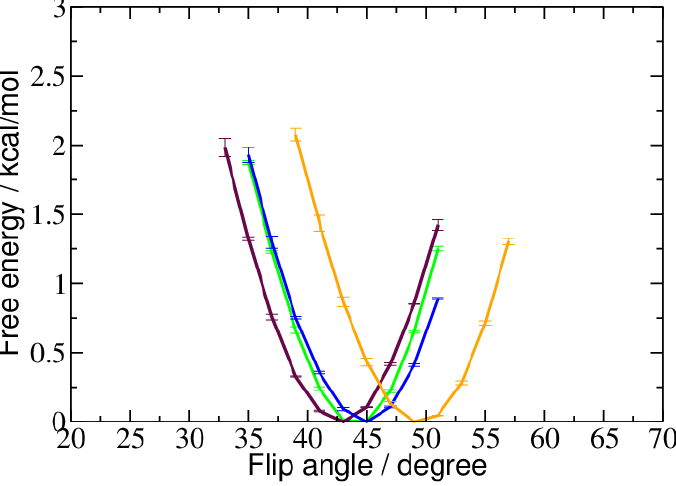
Figure 3. Free energy profiles of the pseudo-dihedral flip angle evaluated from the unbiased MD simulations of 5-methyl-cytosine (green), 5-hydroxymethyl-cytosine